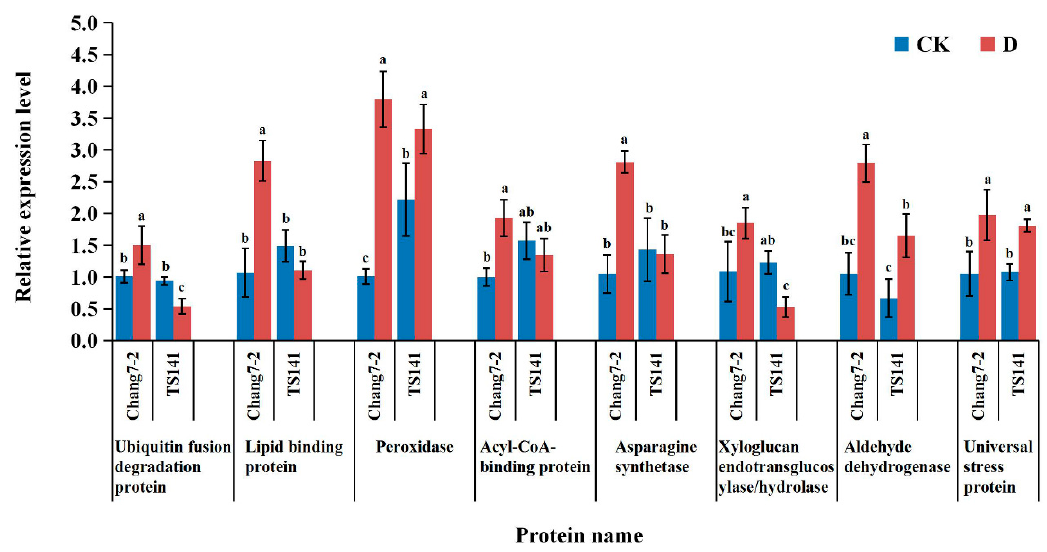
Figure 6. mRNA expression level analysis (qRT-PCR) of eight DEPs under control and stressed conditions. Data are presented as the mean ± standard deviation. Lowercase letters indicate a significant di ff erence at the 5%